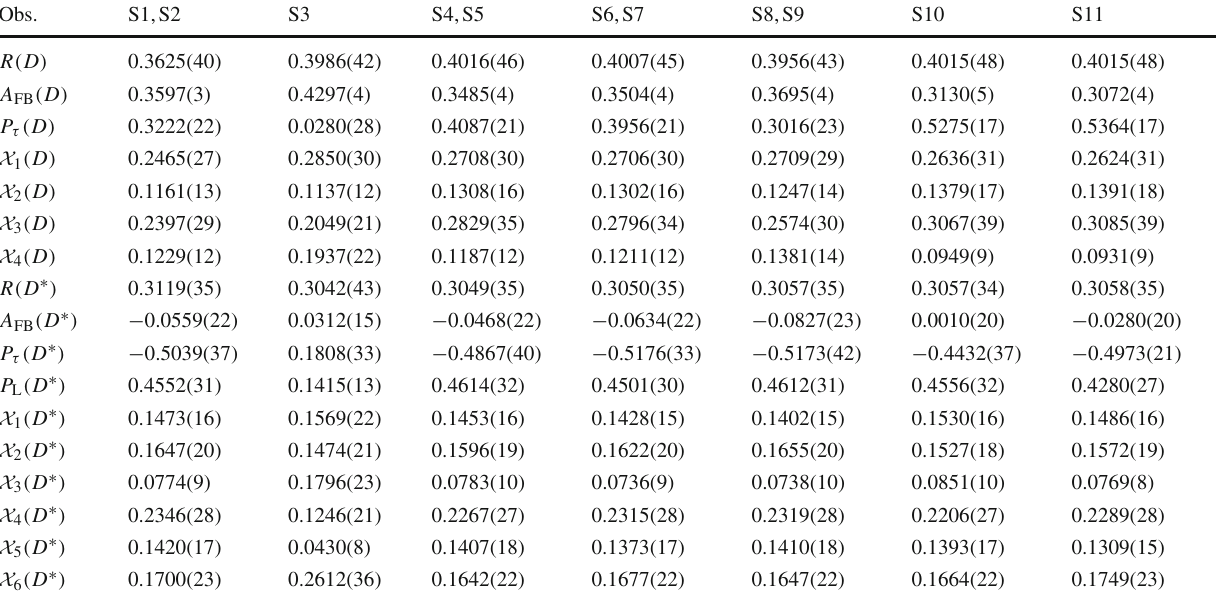
Table 4 Predictions for the observables involved in B → D ( ∗ ) τν decays in all the NP scenarios Obs.